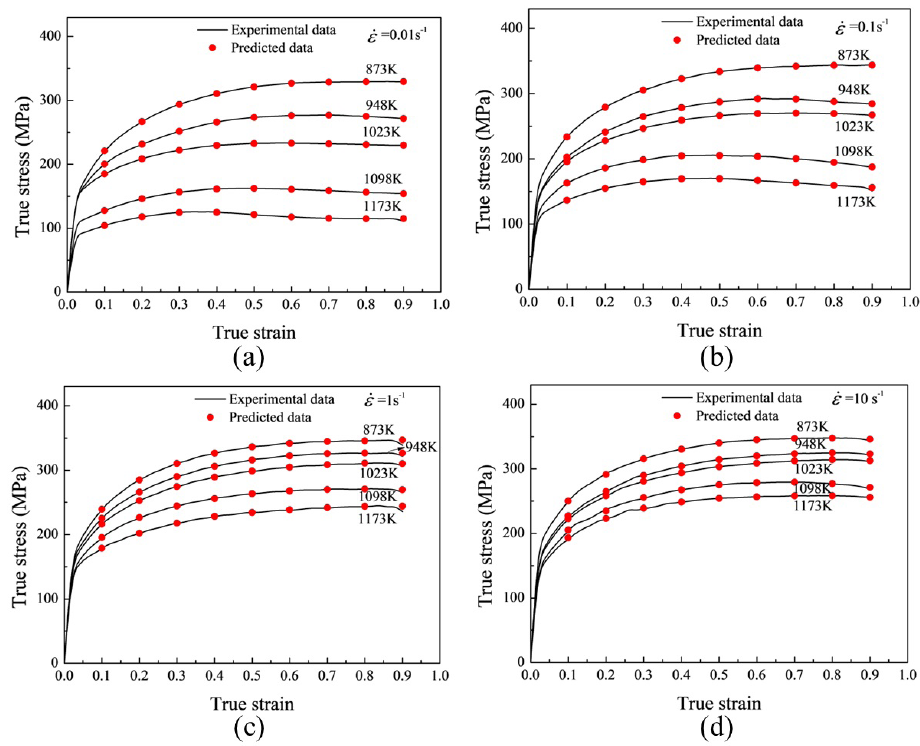
Figure 5. Comparison between the experimental and predicted flow stresses by ANN model at different temperatures and strain rates of (a) 0.01 s −1 , (b) 0.1 s −1 , (c) 1 s −1 and (d) 10 s −1